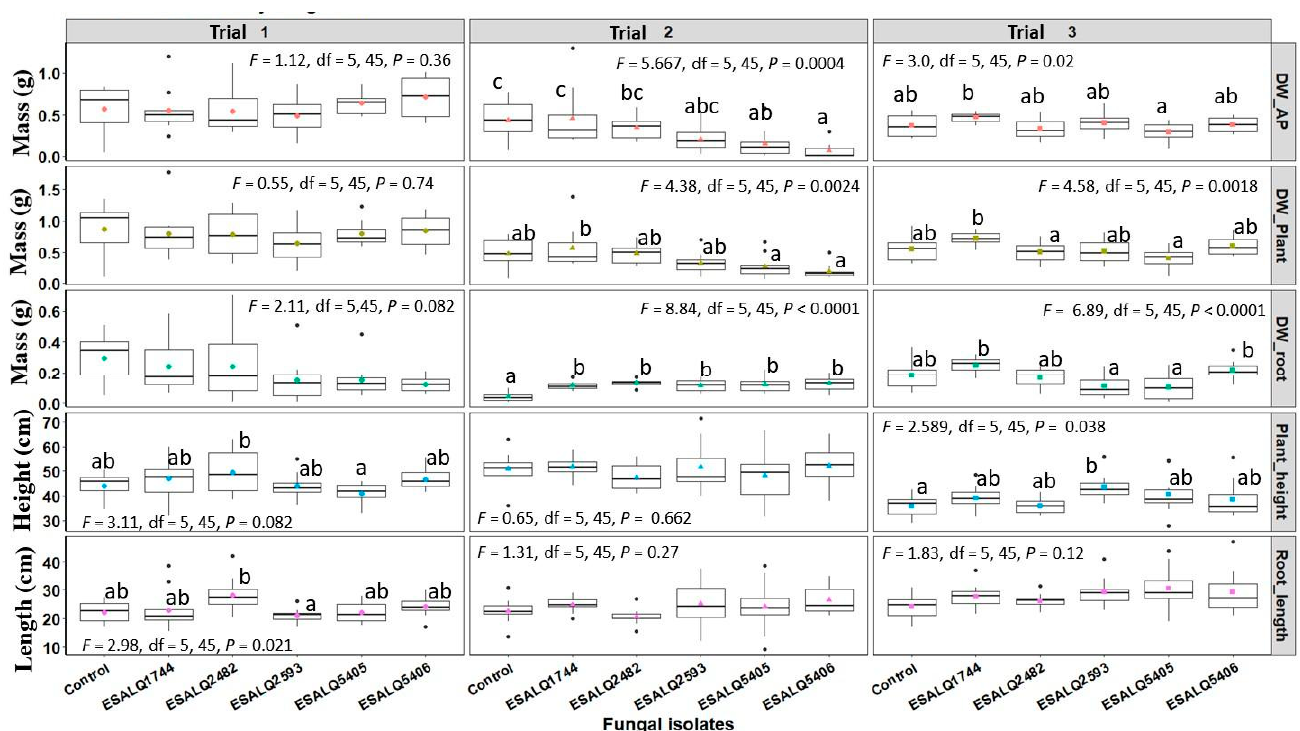
Figure 3. Common bean ( Phaseolus vulgaris ) plant traits (dry weight of the aerial part, total plant dry weight, root dry weight, plant height, root length) after seed treatment with different isolates of Purpureocillium lilacinum (ESALQ1744, ESALQ2482, and ESALQ2593) and Pochonia chlamydosporia (ESALQ5405 and ESALQ5406) at 45 days after fungal inoculation and seeding, under greenhouse conditions. Colored symbols inside boxplots represent means (± S.E., n = 10 plants per experiment and treatment), and treatments with no letters in common are statistically different at p < 0.05 based on Tukey HSD. Plant traits evaluated: dry weight of aerial part (g, DW_AP), dry weight of whole plant (g, DW_Plant), dry weight of roots (g, DW_root), plant height (cm), and root length (cm). A decrease in the weight of the aerial part of the plants was observed for P.